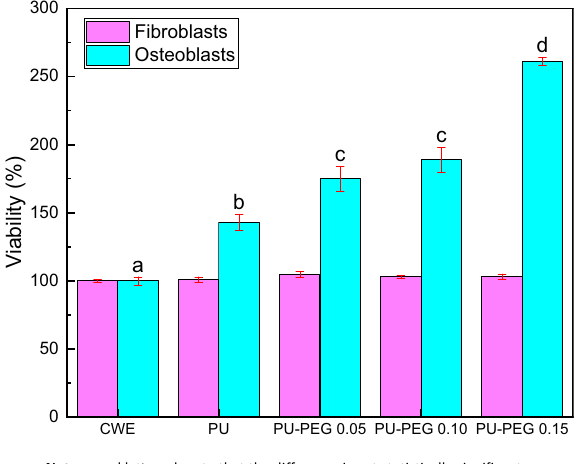
Fig. 7 Cell viability of osteoblast and fi broblasts cells by indirect contact with PU substrata for 24 h. CWE: cells without contact with extracts of the fi lms. P < 0.001, one-way ANOVA with Tukey ’ s multiple comparison test, n = 5 in each